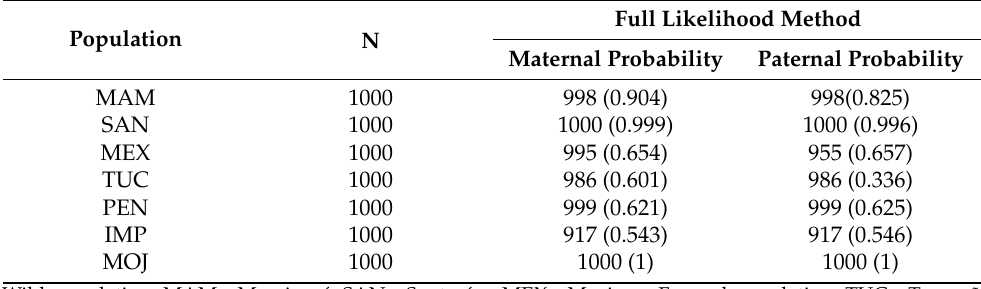
Table 3. Individual identification of simulated genotypes of Arapaima gigas from three wild and four farmed populations. Population N